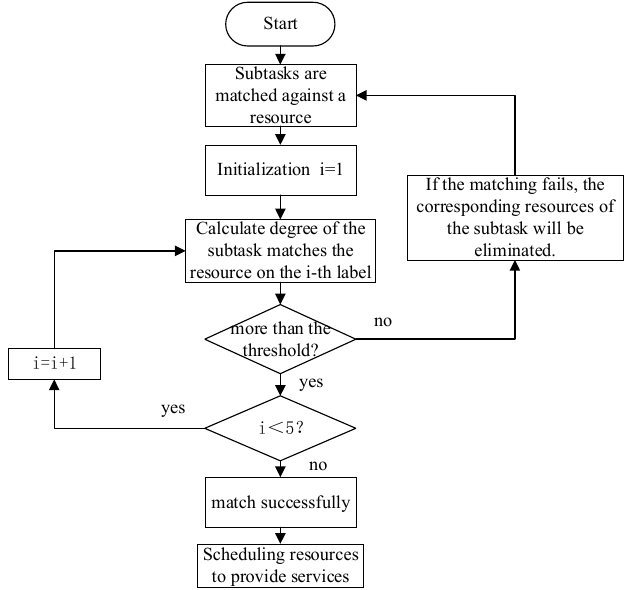
Figure 7. Flow chart of matching based on multi-level tags.